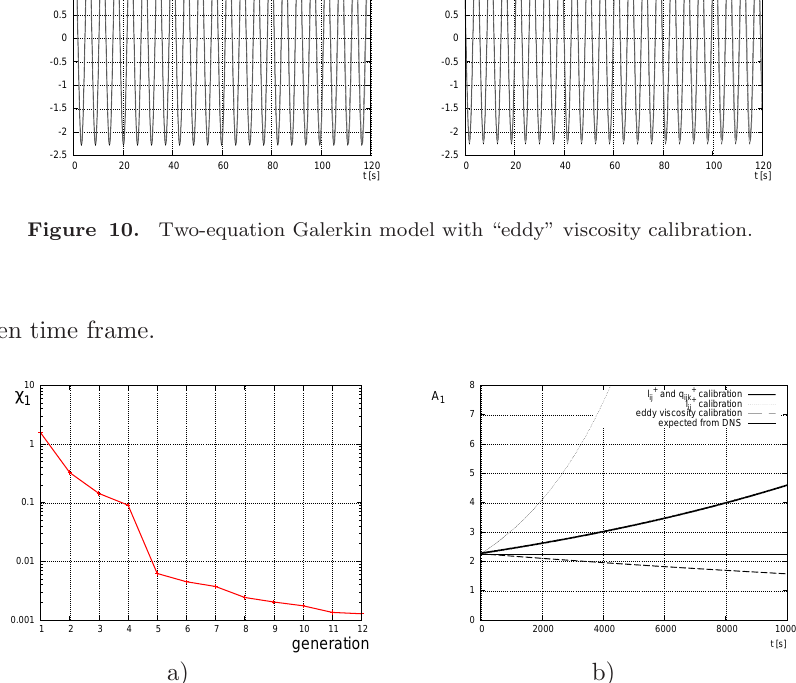
Results of experiments: a) prediction error χ 1 for two-equation Galerkin model with Poincar´e calibration of l + ij and q + ijk terms in consecutive iterations of genetic algorithm, b) amplitude of first mode coefficient for two-equation Galerkin